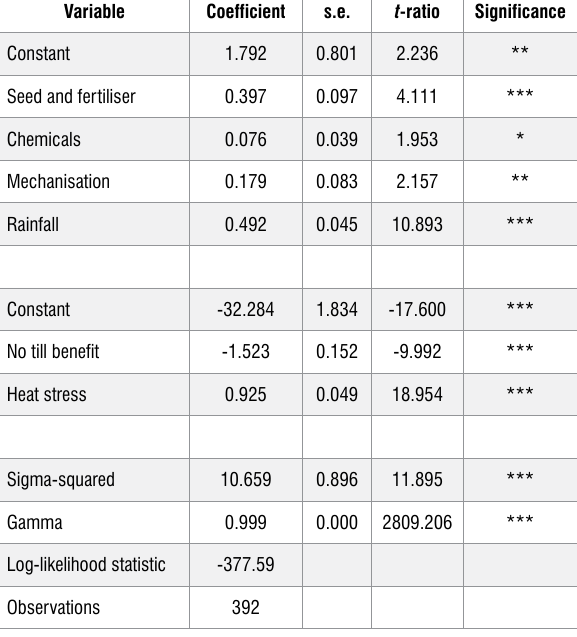
Table 2: Baseline grain productivity model (Model 0) with no till benefits and heat